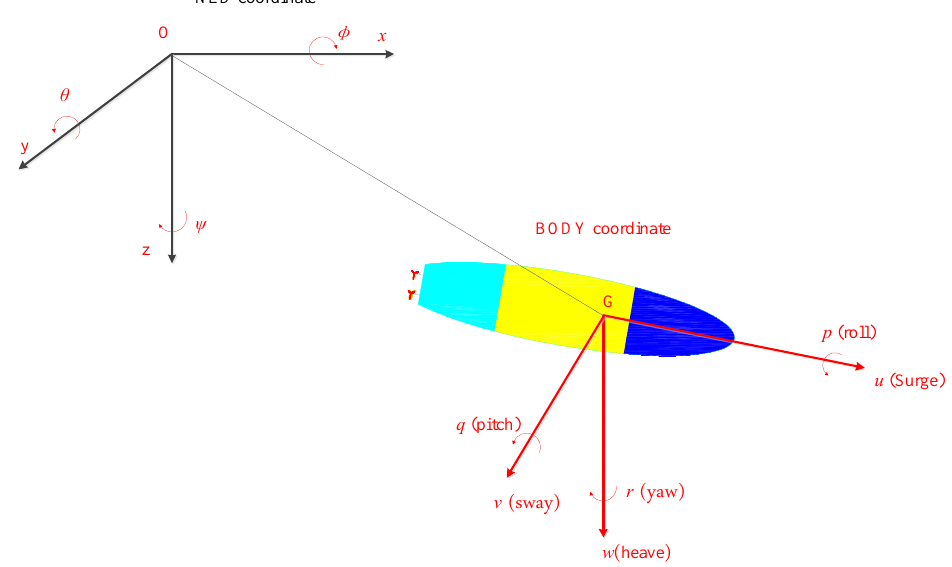
Figure 1. Earth ‐ inertial frames and body ‐ fixed reference frames. Figure 1. Earth- inertial frames and body-fixed reference